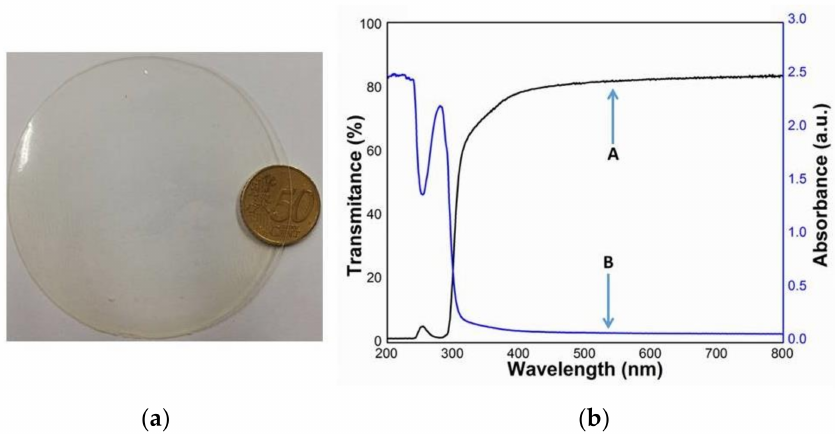
Figure 1. Film obtained at pH 12 with unheated whey proteins (WPs) in the presence of 50% glycerol (GLY) ( a ) and its whole transmittance (A) and absorbance (B) spectra ( b ).